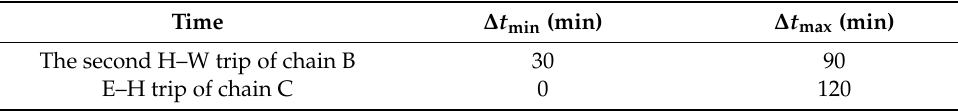
Table A3. Values of ∆ t min and ∆ t max for different